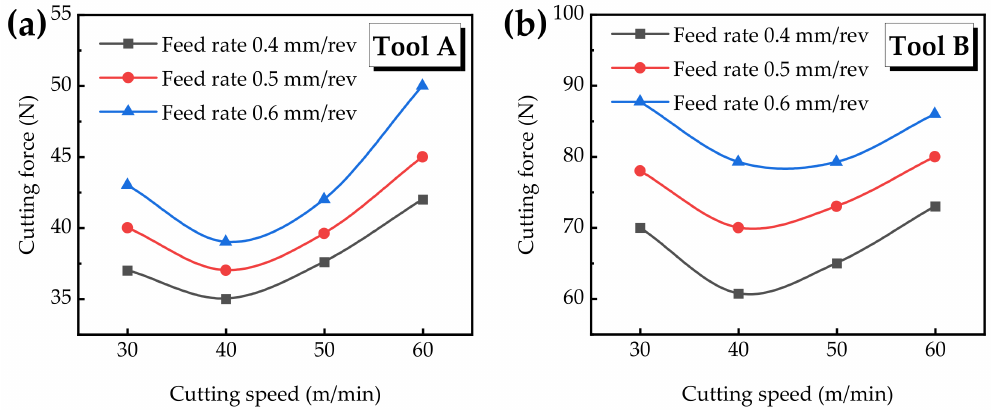
Figure 3. Cutting force versus different cutting